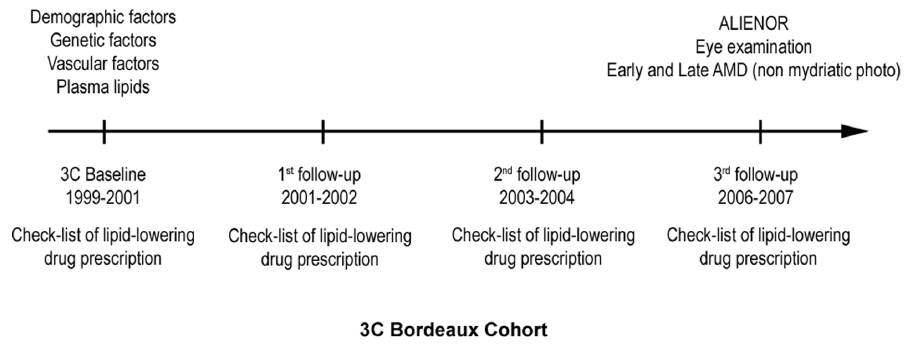
Figure 1. Design of the Alienor study. Abbreviations: AMD: age-related macular degeneration.